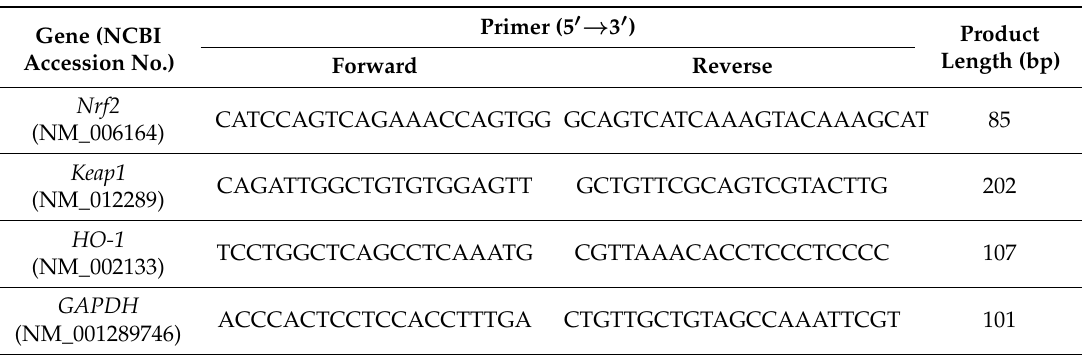
Table 1. Primer sets for real-time